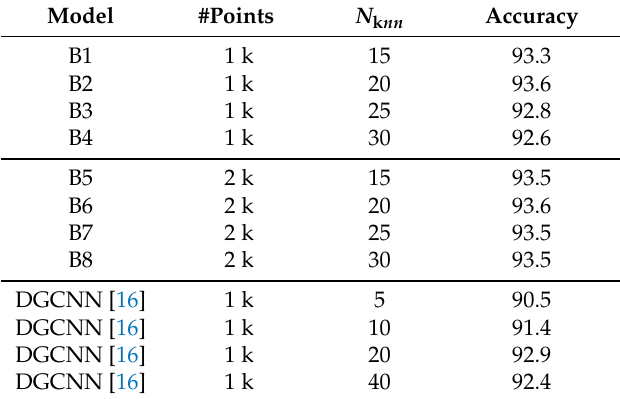
Table 7. Ablation study of AttPNet on ModelNet40 dataset. N k nn indicates the number of points in a neighboring